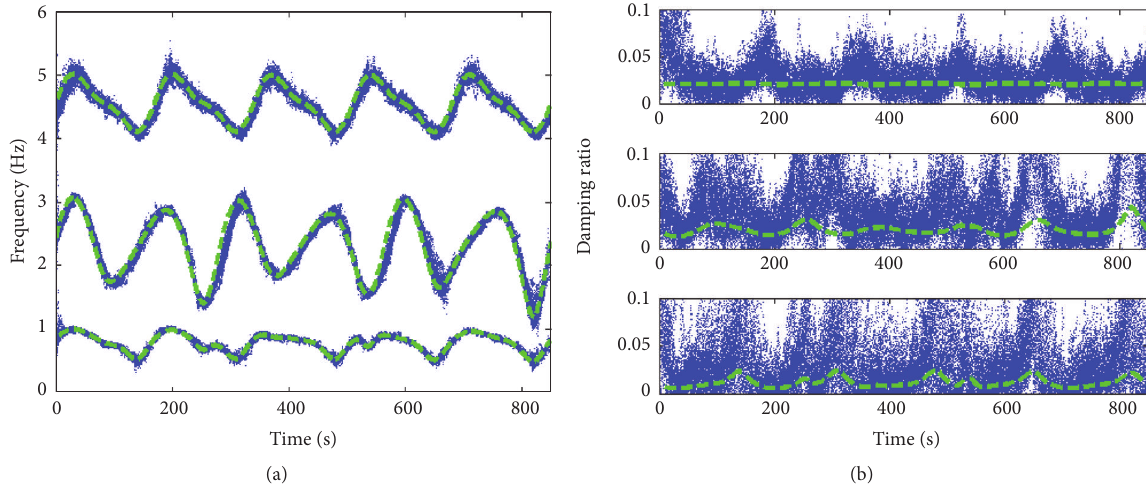
Figure 5: Exponentially weighted RPLR-TARMA based modal parameter Monte Carlo estimates (30 realizations): (a) natural frequency estimates and (b) damping ratio estimates.